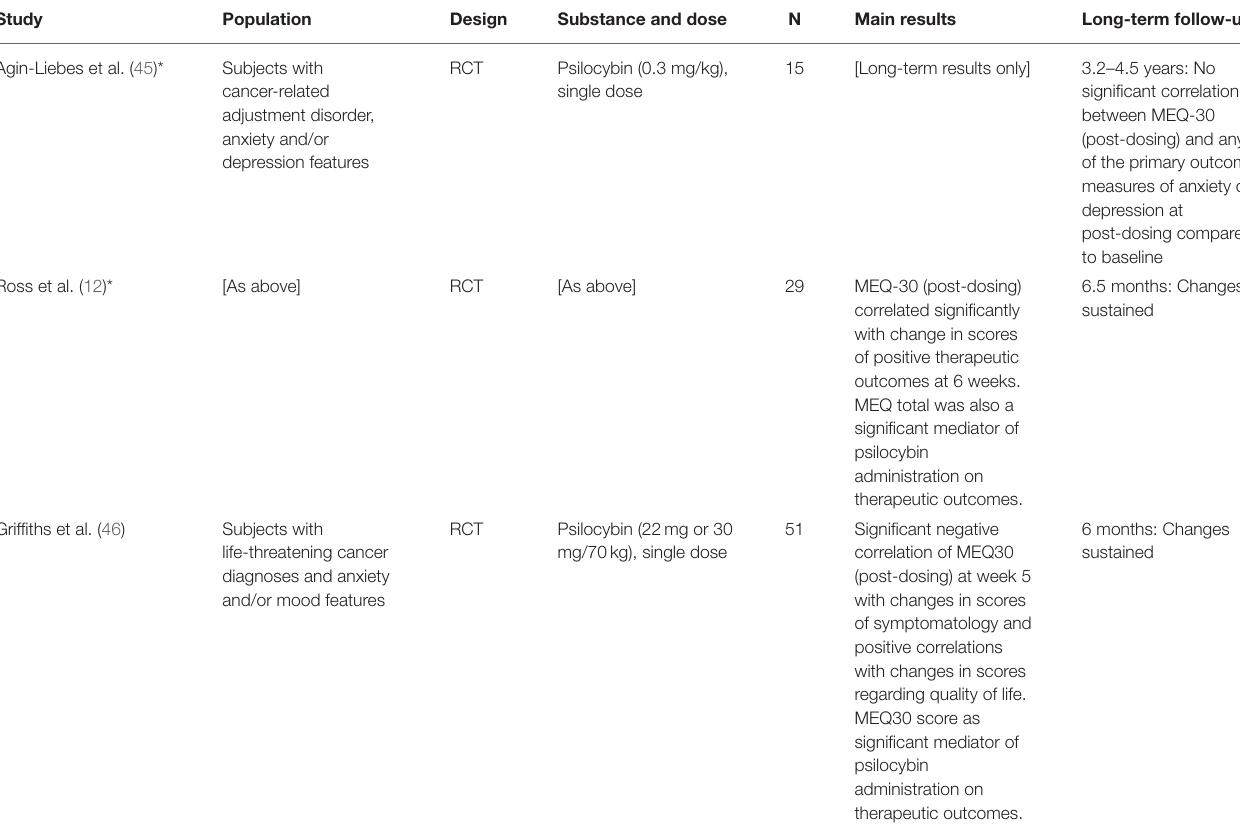
TABLE 3 | Cancer-related distress